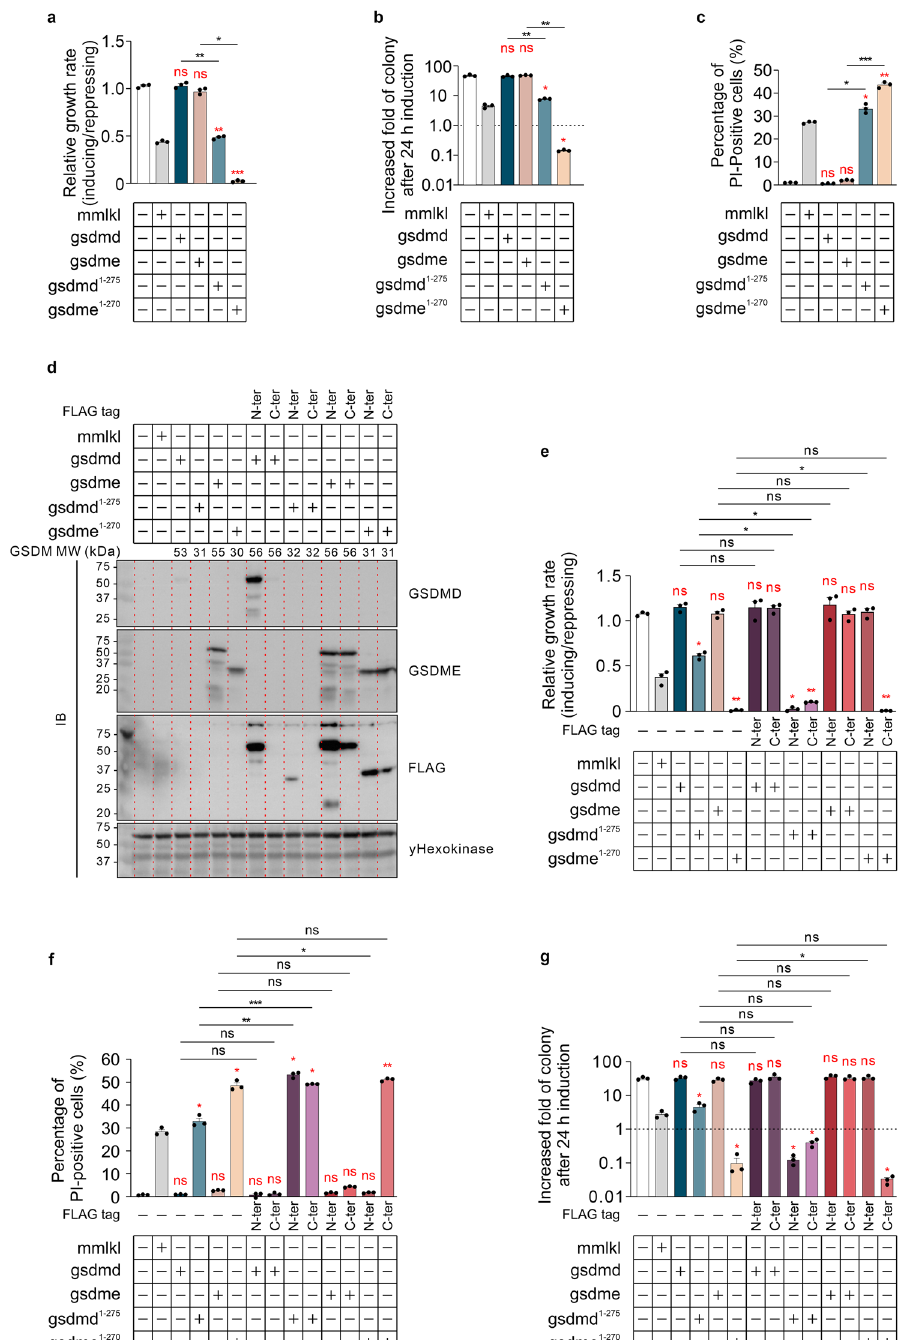
Figure 1. Overexpression of gasdermins in S. cerevisiae . Maximal growth rates of yeast bearing expression plasmids encoding ( a ) wild type or ( e ) FLAG-tagged full-length and N-terminus of GSDMD and GSDME, or empty vectors lacking transgenes, were analyzed by monitoring absorbance of yeast cultured in both inducing and repressing liquid media. Yeast transformants were grown under inducing condition for 24 h then clonogenicity and membrane integrity were assessed. Following galactose removal, yeast expressing wildtype ( b ) or FLAG-tagged ( g ) proteins were evaluated by clonogenicity assay, where yeast were diluted, and incubated on solid repressing media for 3 days before counting. The colony-forming ability of the post-induction yeast culture were assessed by increasing fold of colonies relative to each uninduced culture. The membrane integrity of yeast expressing wild type ( c ) or FLAG-tagged proteins ( f ) were analyzed by propidium iodide (PI) uptake flow cytometry. Expression of recombinant expressed wild type or FLAG-tagged GSDMD and GSDME were assessed by western blot ( d ). Predicted molecular weights of the different forms of gasdermin proteins are noted above the blots. Loading control: anti- γhexokinase. Uncropped blots are presented in Supplementary Fig. 1. Data present mean ± SEM of three independent assays. Statistical analysis of differences in growth rates, membrane integrity and clonogenic ability were compared using ANOVAs with Sidak corrections. Comparisons made between data from empty vector yeast and those expressing each transgene were labeled in red color. *, P < 0.05; **, P < 0.01; ***, P < 0.001; ns, not